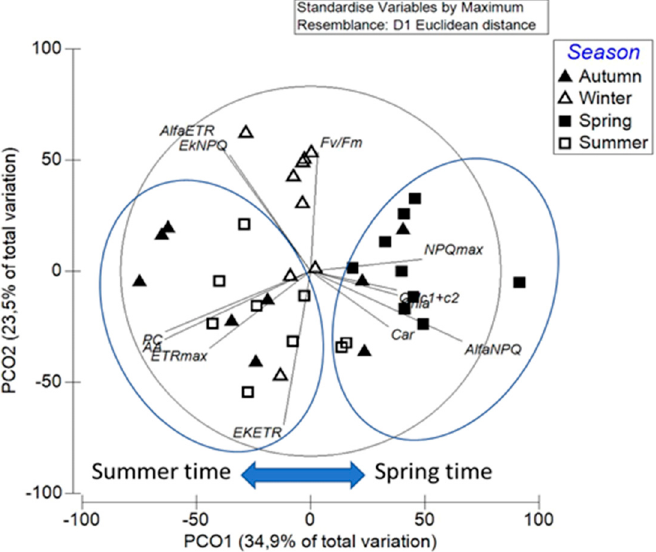
Figure 3. Principal coordinates diagram in relation to season (spring, summer, autumn, and winter). Vectors overlay (Spearman rank correlation) indicates the relationship between the PCO axes and the ecophysiological ( F v /F m , ETR max , Alfa ETR , Ek ETR , a NPQ , NPQ max , Ek NPQ ), and biochemical (PC, AA, Chl a , Chl c1+c2 and Car) variables throughout time.